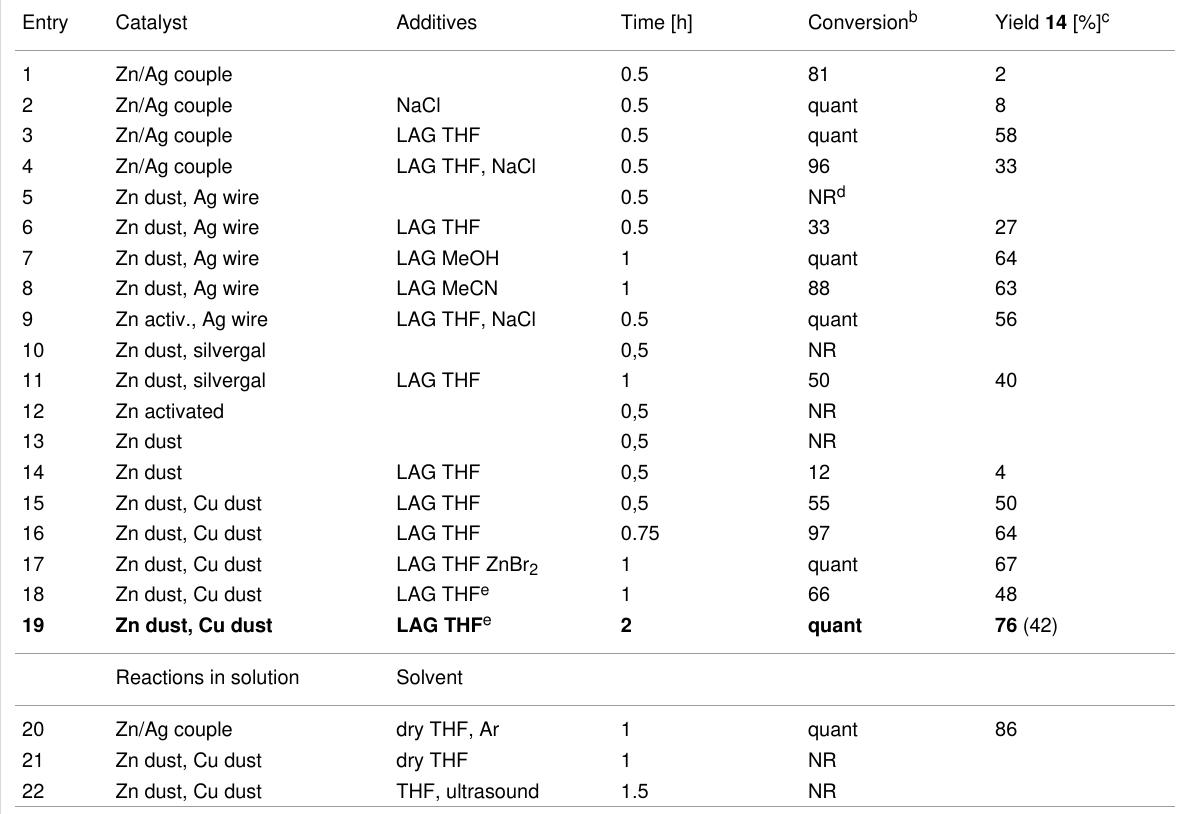
Table 1: Optimization of reaction conditions for reaction of 10 with anthracene. a